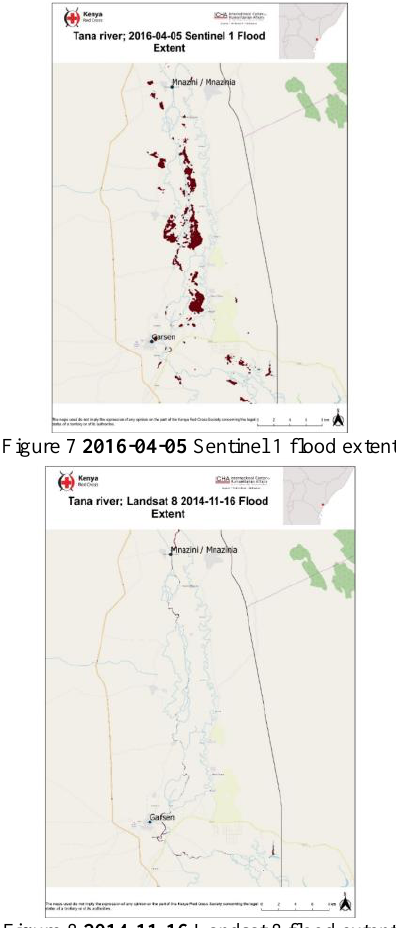
Figure 8 2014-11-16 Landsat 8 flood extent